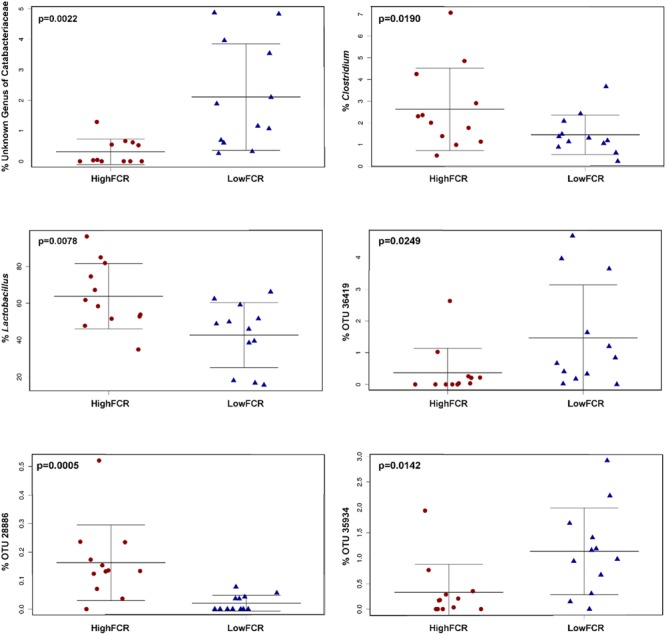
Some of the significantly (FCR) differential genera and OTUs in Trial 2. Genus Clostridium significantly correlated with poor performing (high FCR) birds is of the lineage Clostridiaceae/Clostridium. The closest cultured strain to OTU36419 was Ruminococcus albus (similarity 90.06%), to OTU28886 Lactobacillus reuteri (98.98%) and to OTU35934 C. cellobioparum (83.13%).